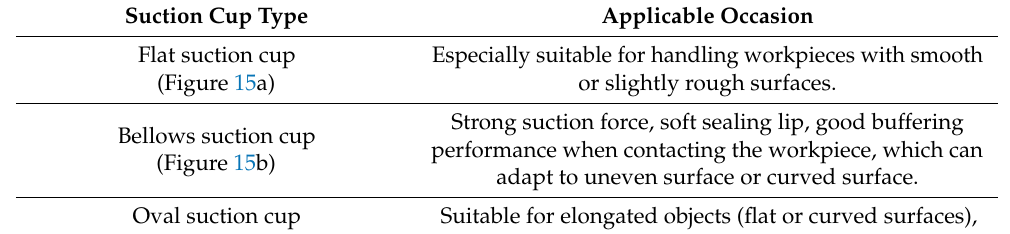
11 of 36 Figure 12. Three-point determination curve. The parametric equation expression of the curve (cid:0) ABC is: 2 1